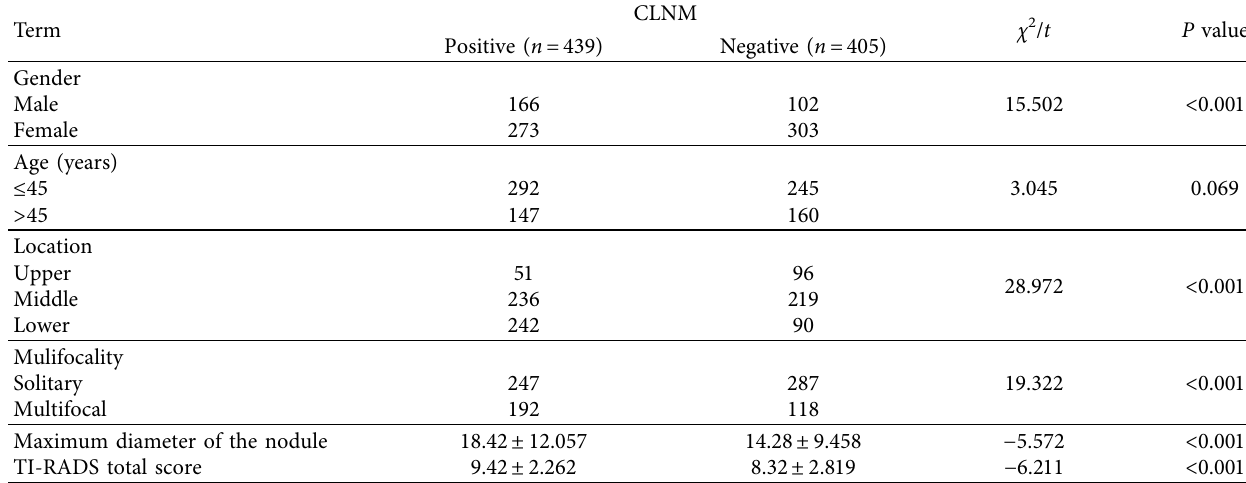
Table 1: Single-factor analysis of lymph node metastasis in the central area of PTC.